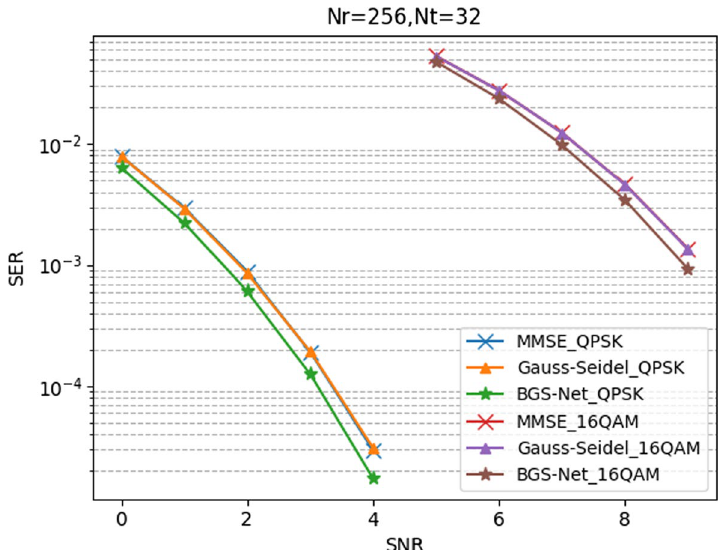
Fig. 16 Comparison of the effect of different modulation methods on SER for N t = 32,N r = 256 , SAUE system